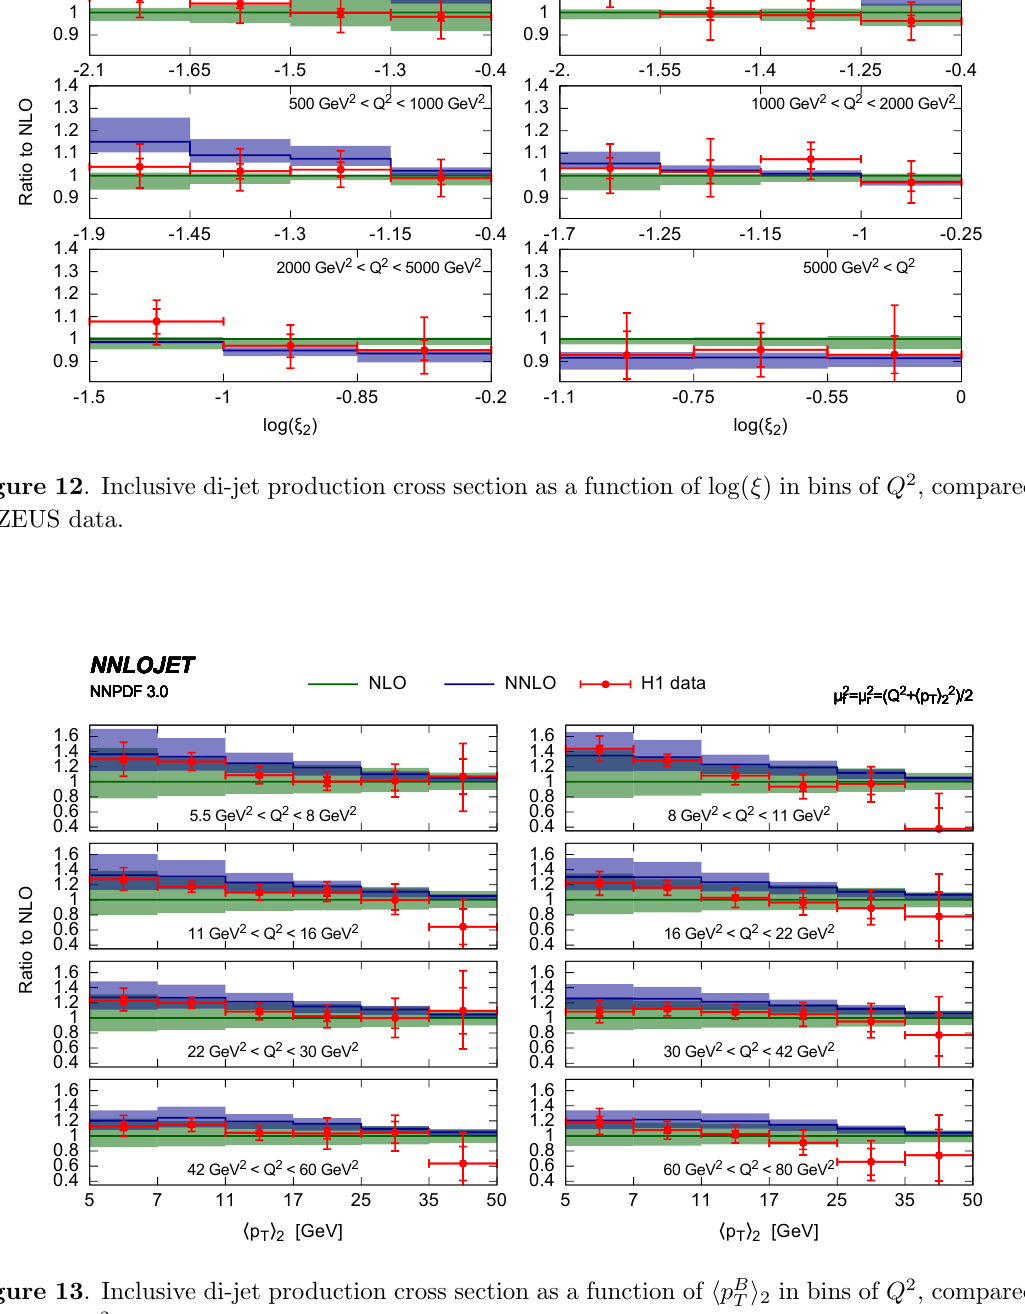
i 2 in bins of Q 2 , compared T